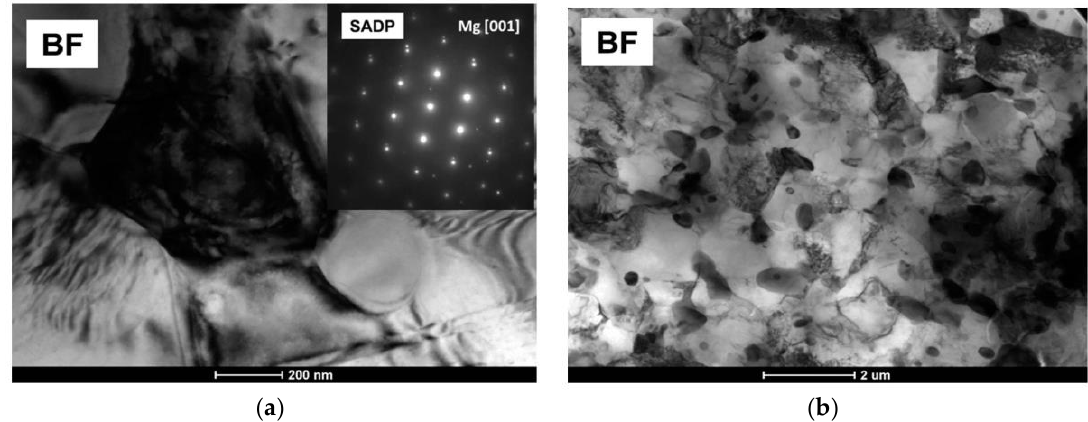
Figure 9. BF microstructures and corresponding SADP of the sample after the third pass: different magnifications, scale 200 nm ( a ) and 2 µm ( b ).